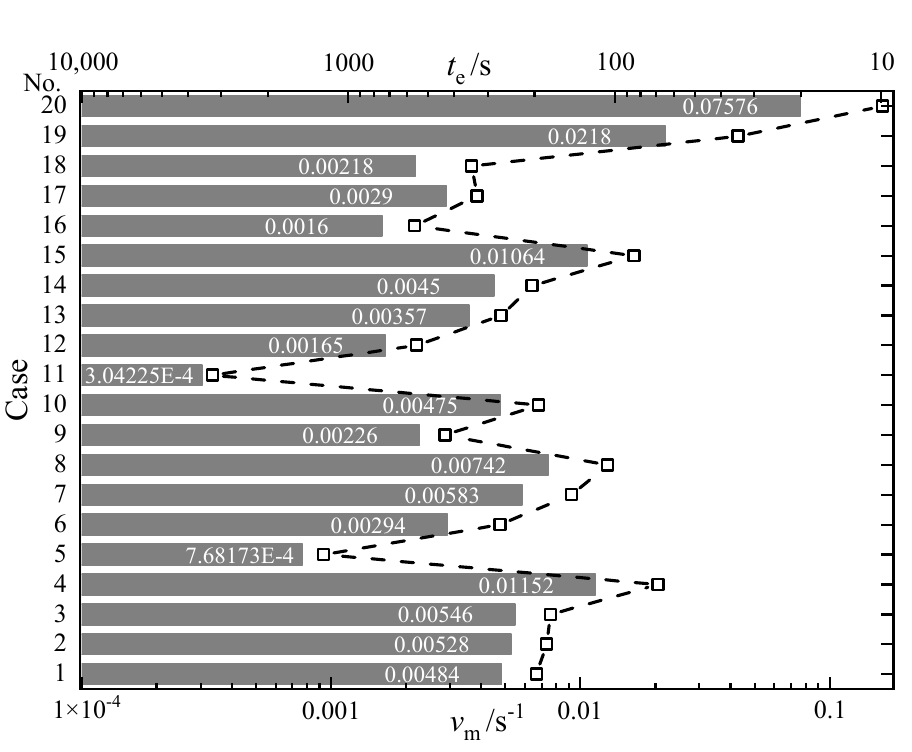
Figure 7. Energy storage time t e and average melting rate v m for alternatives. Figure 8 depicts the melting liquid phase fraction versus time for several alternatives.